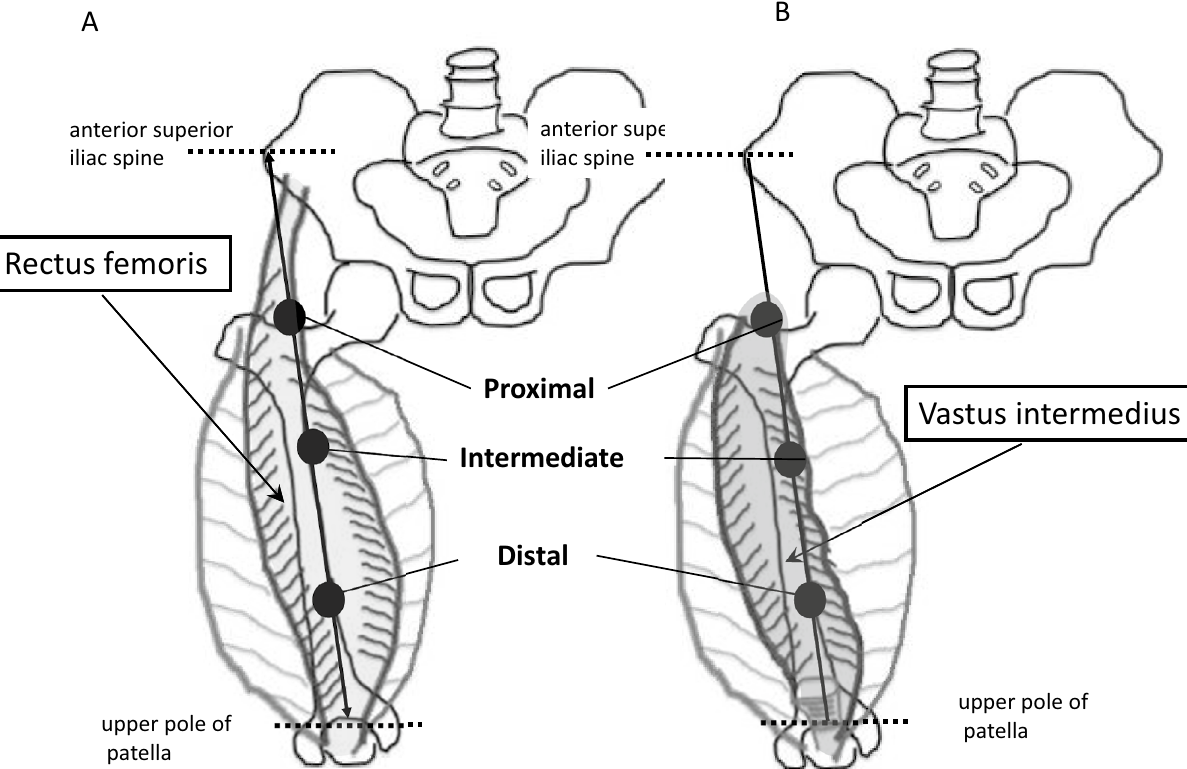
Figure 4. Ultrasonographic measurement sites on the rectus femoris ( A ) and vastus intermedius ( B ). Proximal point, on the anterior surface, 25% proximal to the point between the anterior superior iliac spine and upper pole of the patella; intermediate point, on the anterior surface midway between the anterior superior iliac spine and upper pole of the patella; distal point, on the anterior surface, 75% distal to the point between the anterior superior iliac spine and upper pole of the